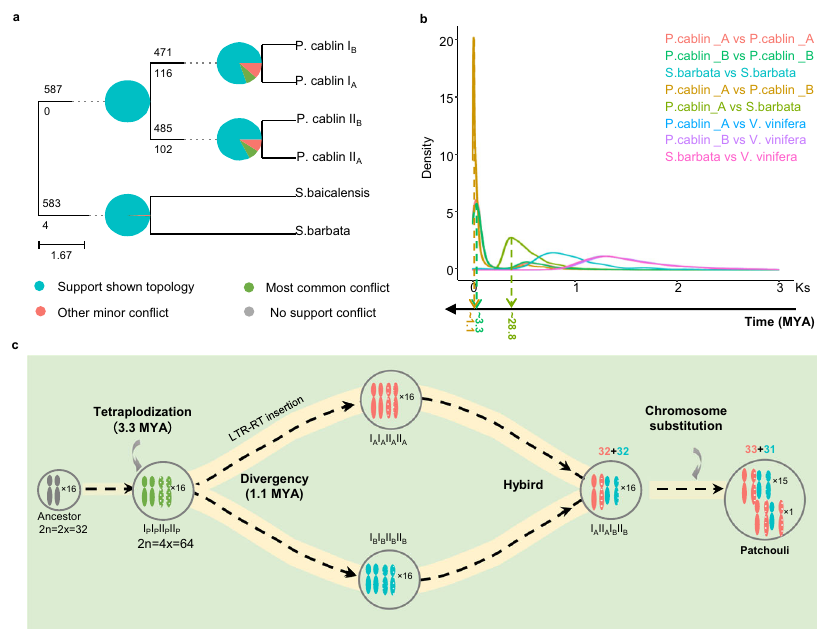
Fig. 6 Evolution of patchouli genome. a ASTRAL-III tree with summary of con fl icting and concordant gene trees produced with Phyparts (v0.0.1). For each branch, the top number indicates the number of gene trees concordant with the species tree at that node, and the bottom number indicates the number of gene trees in con fl ict with that clade in the species tree. The pie charts at each node present the proportion of gene trees support each type. b Kernel density plots for corrected Ks between genomes among patchouli subgenome A, patchouli subgenome B, Scutellaria barbata , and Vitis vinifera genomes. c Evolutionary scenario of patchouli genome. Solid line represents chromosomes from I group, mosaic line represents chromosomes from II group. Orange line represent chromosomes from subgenome A and cyan line represent chromosomes from subgenome B. MYA is an abbreviation for million years